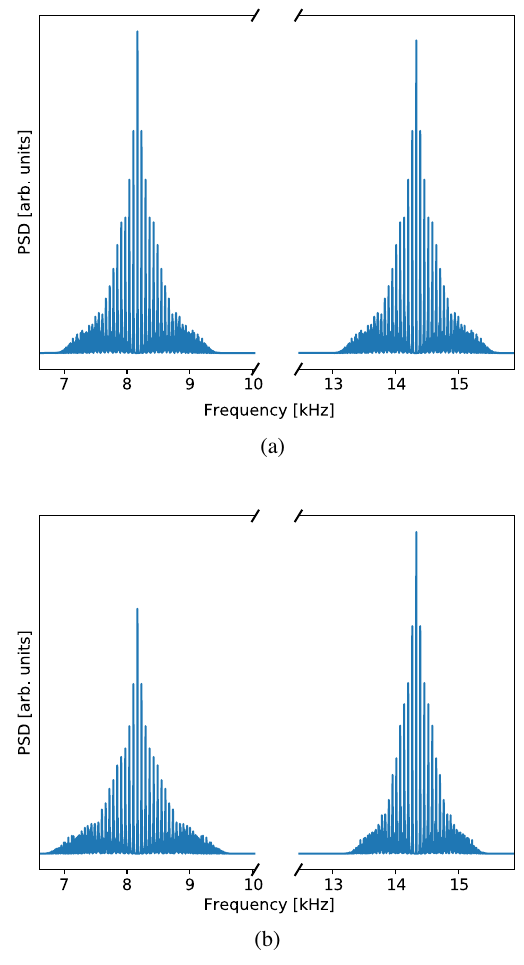
FIG. 2. Power spectral densities of the cumulative bunch dipole moment, presented for two different values of chromaticity. Typical for the LHC values of synchrotron frequency, betatron tune, and bunch profile are assumed. (a) Q ξ ¼ 0 (b) Q ξ ¼ 20